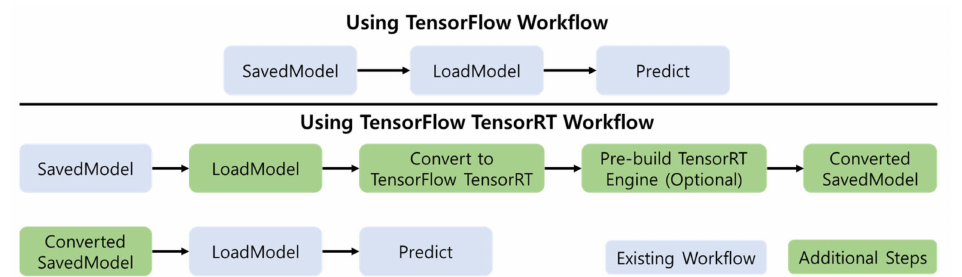
Figure 6. The workflow comparison processing process of TensorFlow and